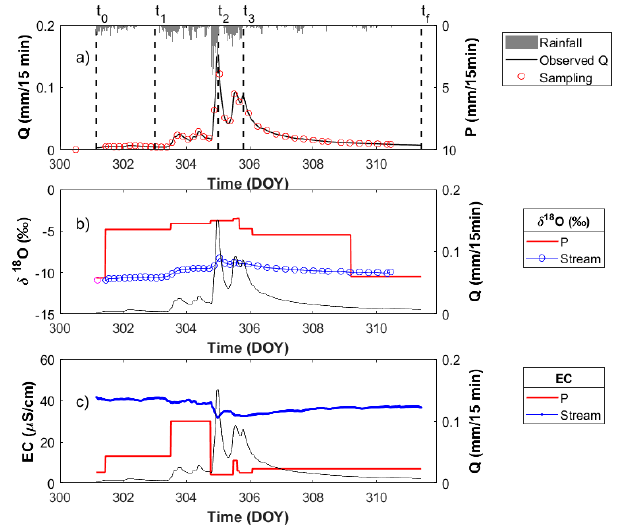
Figure 3. Temporal variability of the hydrometric and tracer data during the event monitored between 28 October and 7 November 2015 at Mack Creek. ( a ) Rainfall ( P ), runoff ( Q ), and sample collection times. Vertical dashed lines (t 0 − t f ) indicate periods described in Section 3.1; ( b ) δ 18 O in stream and P ; and ( c ) electrical conductivity (EC) in stream and P .